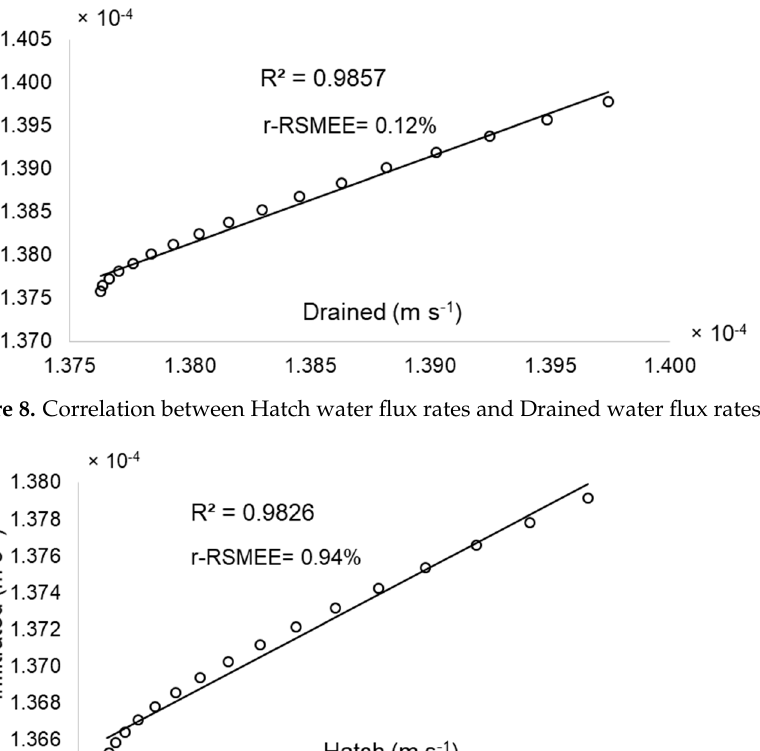
Figure 10. Correlation between Infiltrated water flux rates and Drained water flux rates. As described by Loutfi et al. [45], R 2 expresses the correlation between the measured values and the estimated ones; the best approximation corresponds to the highest R 2 (closer to 1), RMSE shows